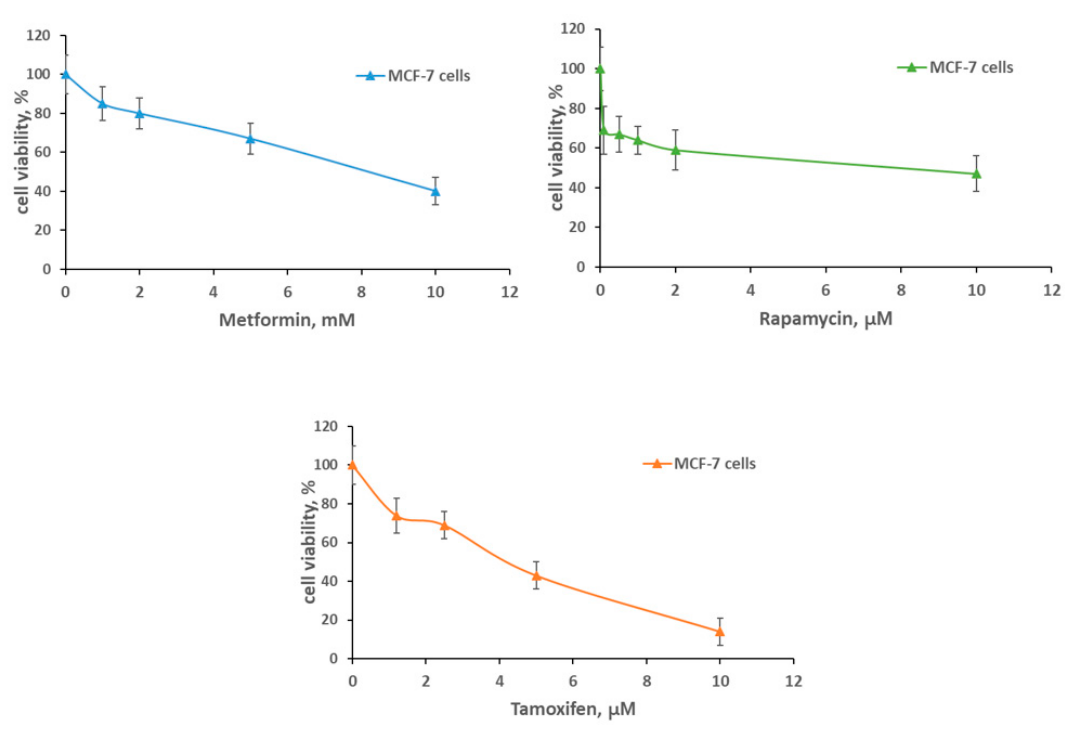
Figure A1. Dose-response curves for metformin, rapamycin, and tamoxifen. MCF-7 cell viability was assessed by the MTT test after 72h growth with compounds. The IC 50 values were 5.8 mM for metformin and 4.1 µ M for tamoxifen. The IC 50 calculation for rapamycin was not validated due to the plateau curve.